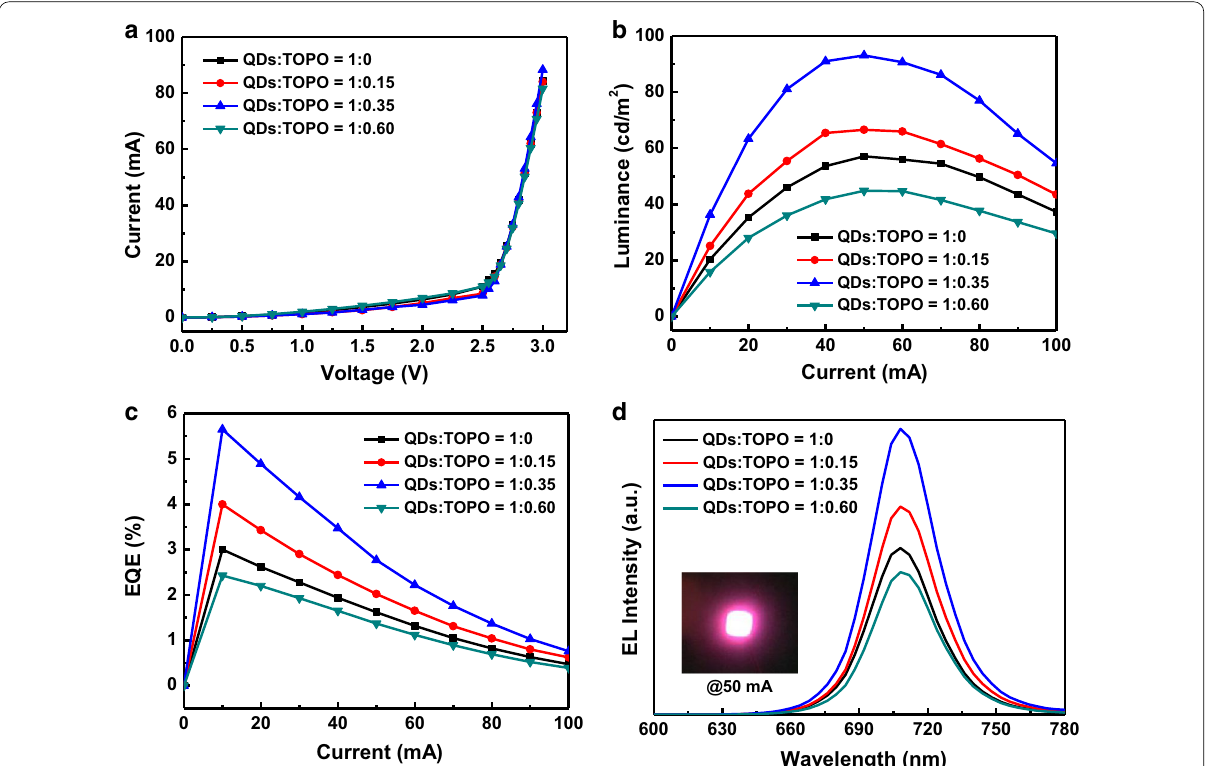
Fig. 7 Performances of CsPbI 3 /TOPO composite‑converted red LEDs under different driving current. a I–V, b L–I, c EQE–I curves, d EL spectra. The inset is an optical photograph of a color‑converted red LED at 50 mA